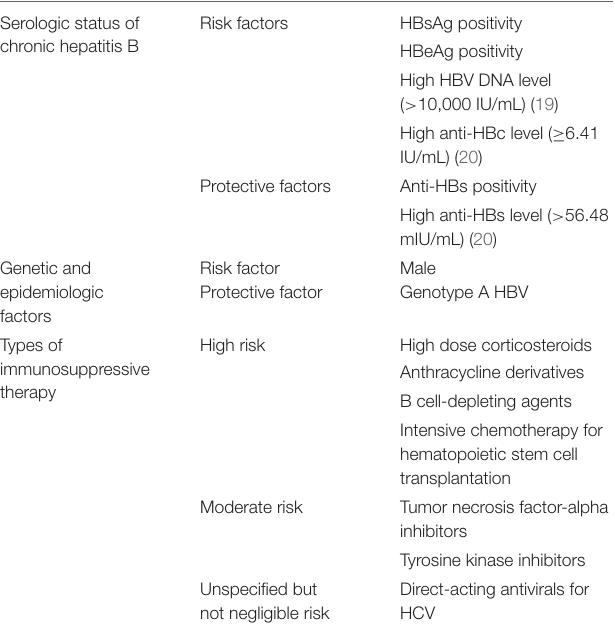
TABLE 1 | Factors affecting reactivation of hepatitis B. Serologic status of chronic hepatitis